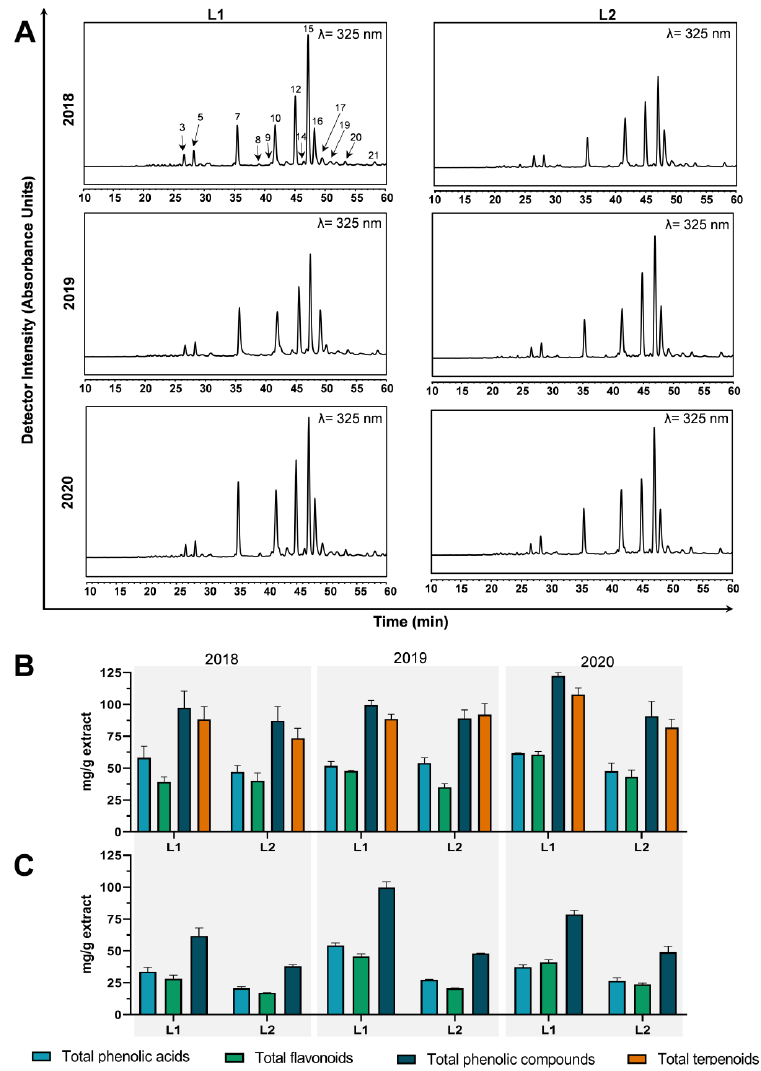
Figure 2. Annual variation (2018 – 2020 period) of T. carnosus phytochemical composition. Chromatograms of phenolic compounds obtained for hydroethanolic extracts ( A ), and, for peak identification and quantification, please refer to Tables S1 and S2. Additionally, there exist variations of total phenolic compounds, phenolic acids, flavonoids, and terpenoids in hydroethanolic ( B ) and aqueous decoction ( C ) extracts obtained by HPLC-DAD analysis. In panel ( A ): 3: caffeic acid; 5: unknown; 7: quercetin- O -hexoside; 8: luteolin- O -hexoside isomer 1; 9: Luteolin- O -hexoside- O -pentoside; 10: luteolin- O -hexoside isomer 2; 12: salvianolic acid A isomer; 14: acetyl-luteolin- O -hexoside-pentoside; 15: rosmarinic acid; 16: salvianolic acid K; 17: salvianolic acid B/E isomer; 19: luteolin- O -hexoside-hexoside isomer 1; 20: quercetin- O -hexoside-hexuronide; 21: luteolin- O -hexoside-hexoside isomer 2.